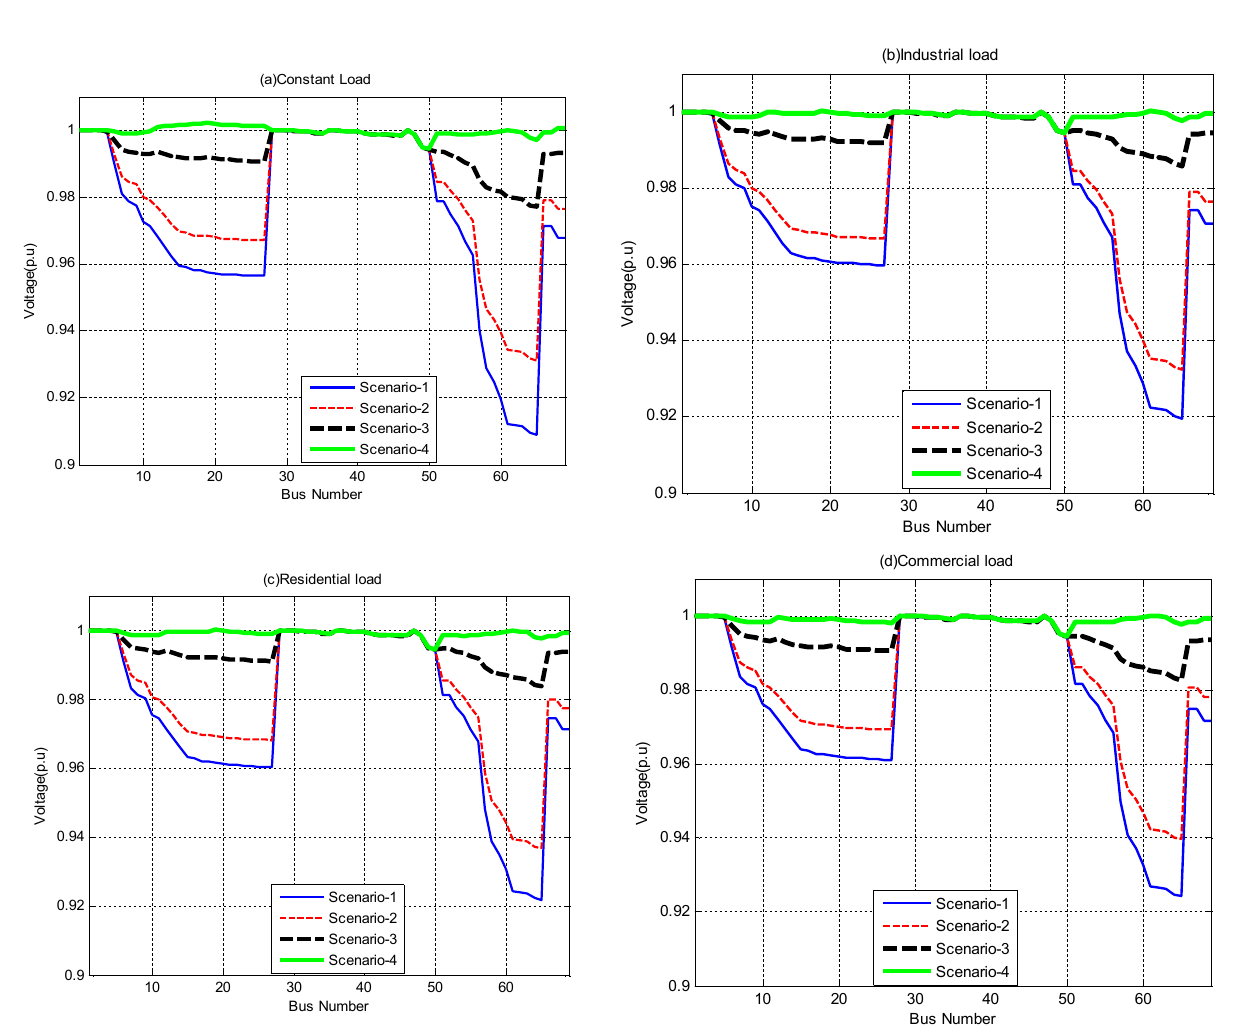
Figure 15. ( a ) Bus voltage comparison of IEEE 69-bus test system under Constant load. ( b ) Bus voltage comparison of IEEE